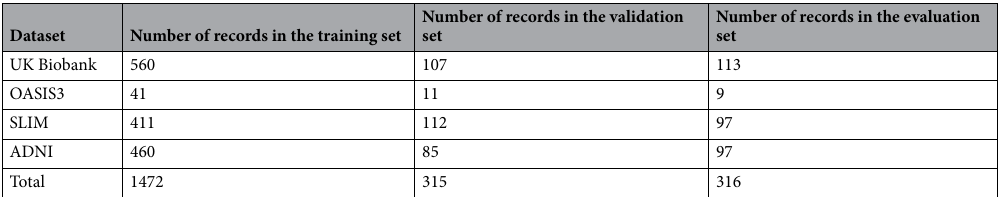
Table 2. Number of records belonging to the sets used for the training, validation, and evaluation of the ReSeg brain segmentation pipeline.